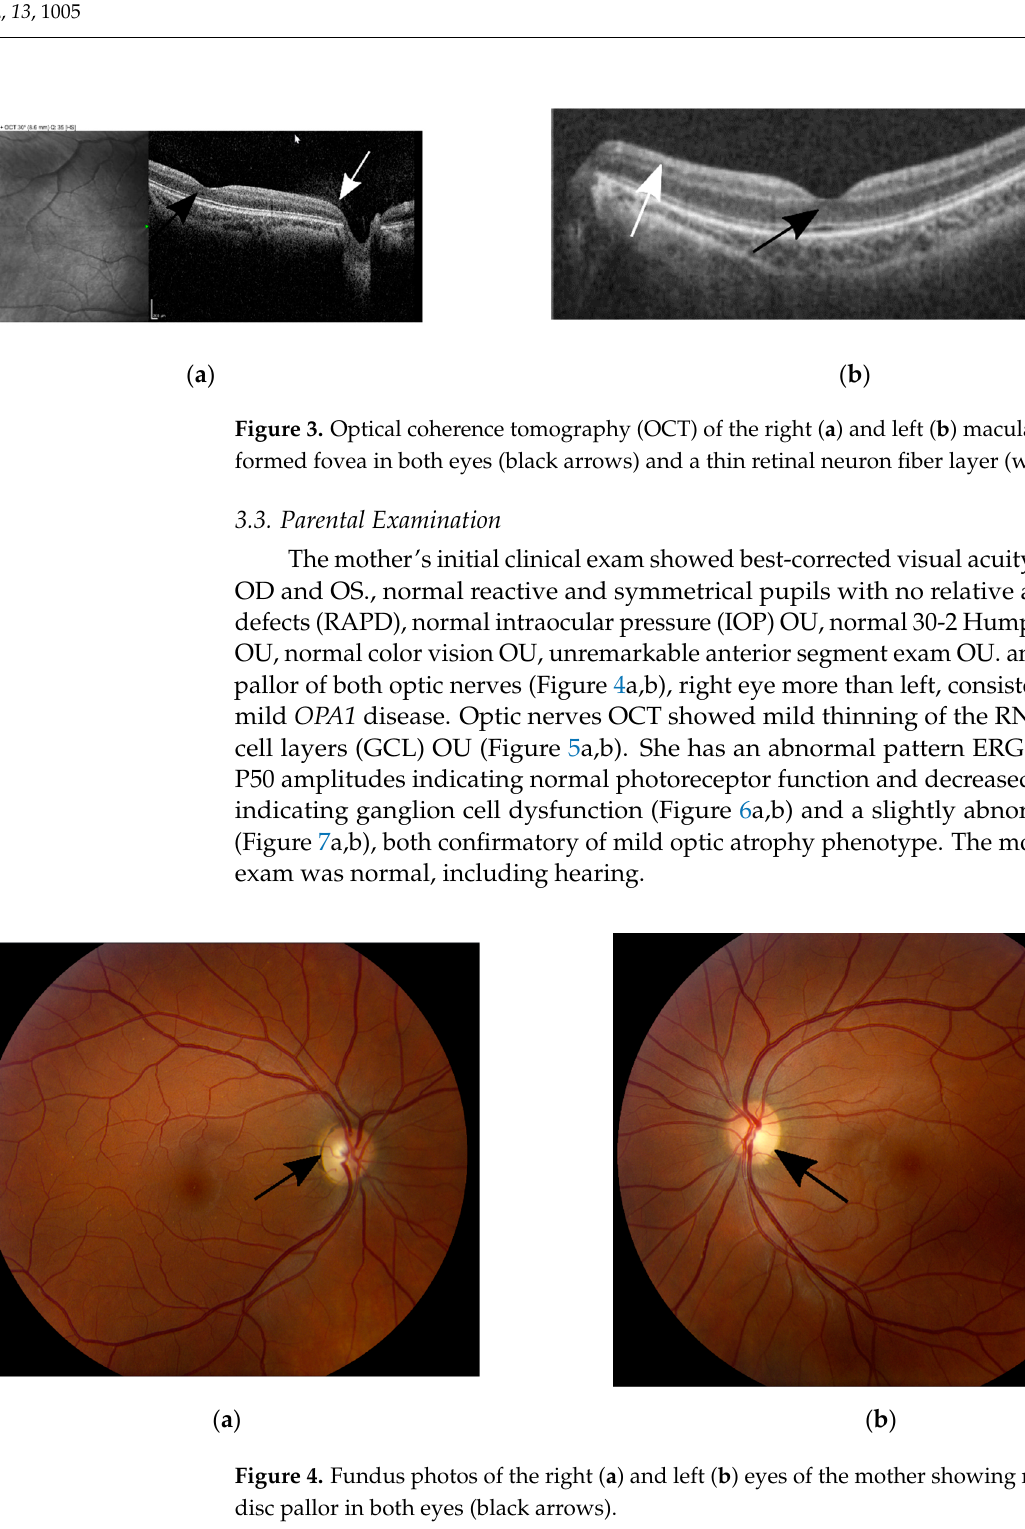
Figure 2. Electrophysiology of the child ( a ) sedated full-field ERG using Burien Allen electrodes and